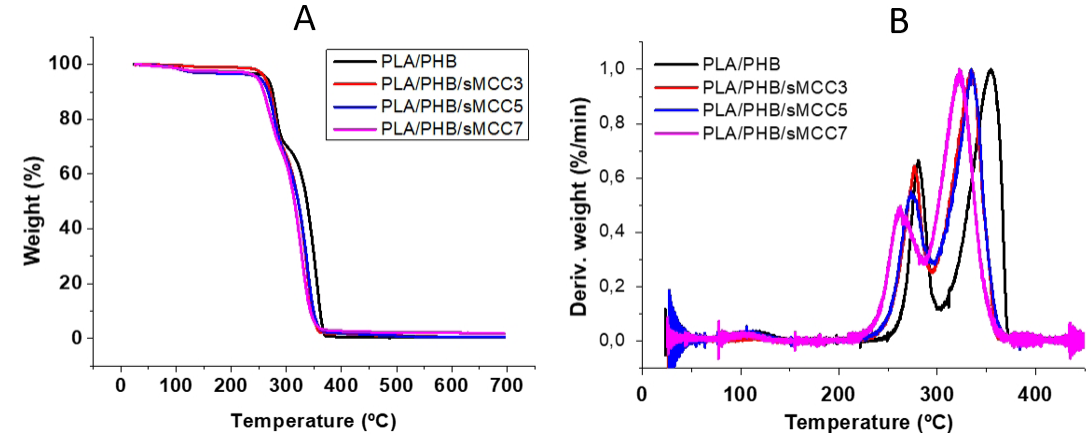
Figure 6. TG curves (A) and DTG curves (b) obtained for PLA/PHB/sMCC biocomposite systems.